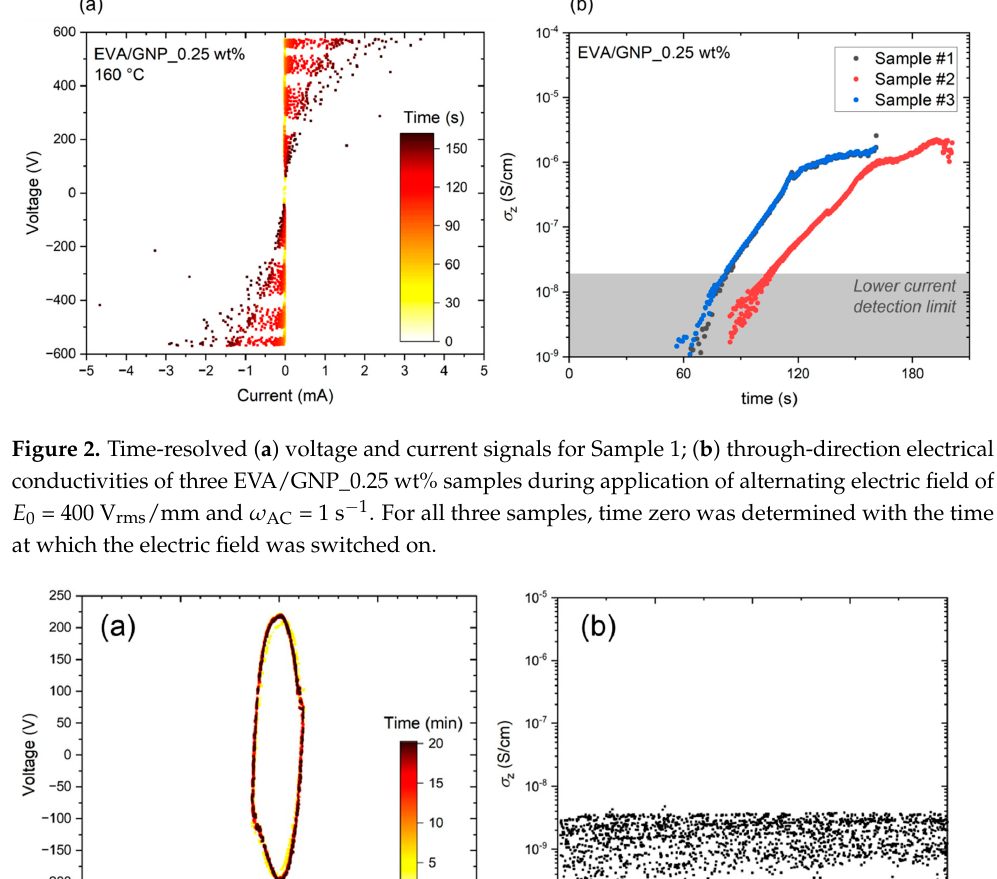
Figure 4. Time-resolved electrical conductivity of EVA/GNP composites during electric field appli- cation. ( a ) GNP concentration fixed at 0.25 wt % with varying electric field strength (400 V rms /mm or 250 V rms /mm) at 160 °C. ( b ) Field strength fixed at 400 V rms /mm with varying temperature (120– 160 °C) to control composite melt viscosity. ( c ) Field strength fixed at 400 V rms /mm with varying GNP concentrations (0.25, 0.10, or 0.05 wt %) at 160 °C; dashed line, fitting with the logistic growth model given by Equation (5). 3.2. TEM Imaging of Composites after Electric Field Application Next, TEM imaging of the EVA/GNP composites was performed to evaluate whether electric field application changed the microstructural morphology of the composite. Due to the softness of the EVA polymer and the black visual appearance of the EVA/GNP com- posite, characterization with the naked eye or optical microscopy was not possible. On the other hand, TEM allows for the direct visualization of GNP dispersion and orientation